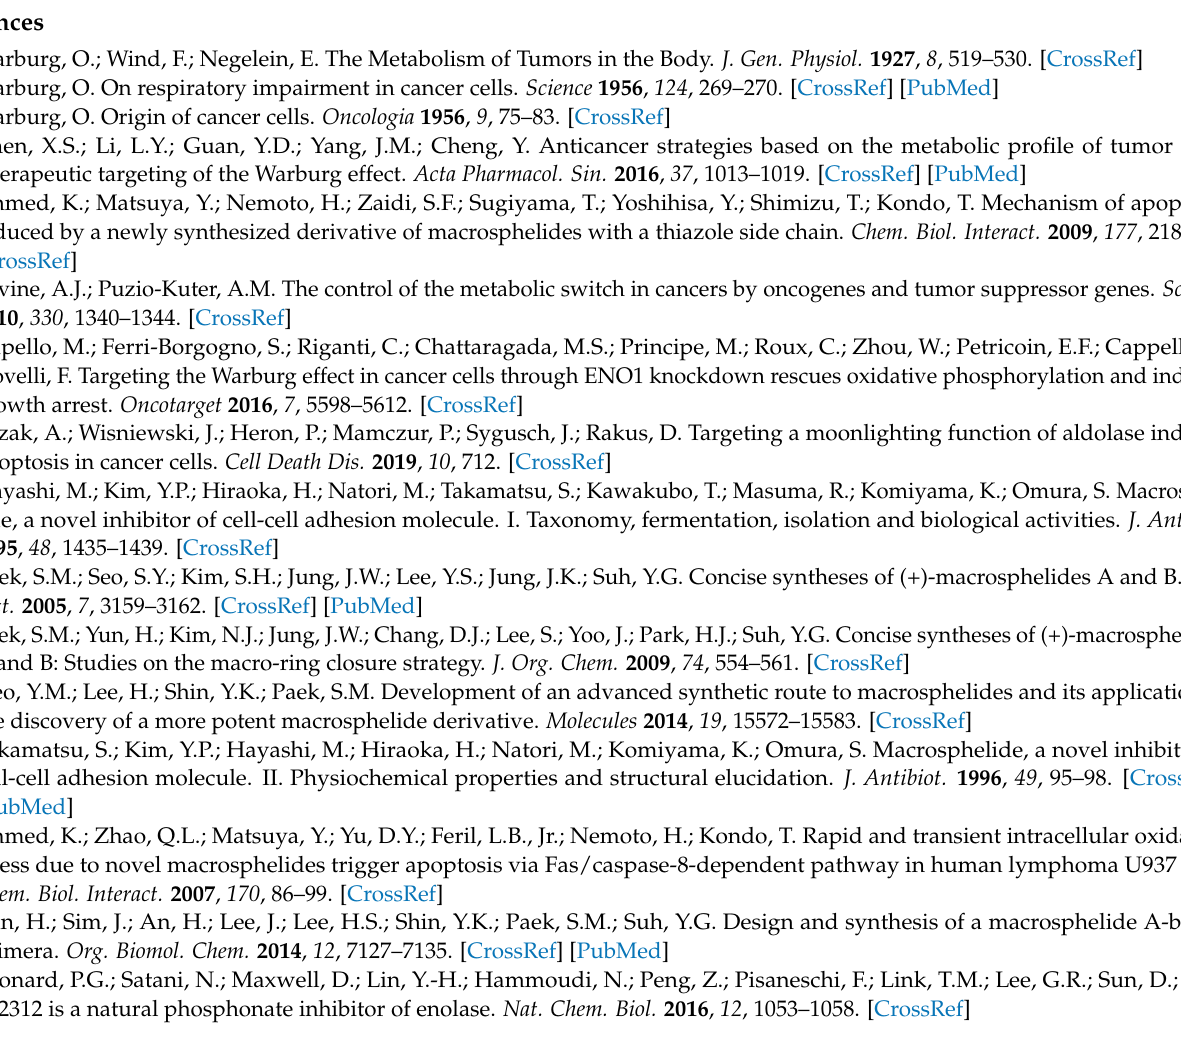
Figure S3: Molecular docking calculation of MSPA-protein complexes, Figure S4: Molecular dy- namics simulation of MSPA-GAPDH, Figure S5: Molecular dynamics simulation of MSPA-FH, Figure S6: Molecular dynamics simulation of MSPA-ENO1, Figure S7: Molecular dynamics simulation of MSPA-ALDOA, Table S1: The primer and probe sequences for